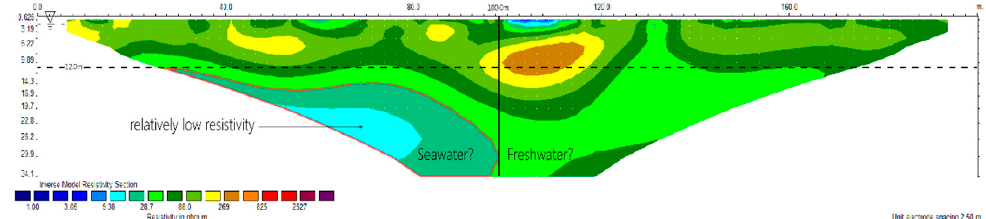
Figure 4. L1 measuring result diagram of the measuring line of the Wenner-Schlumberger Array.